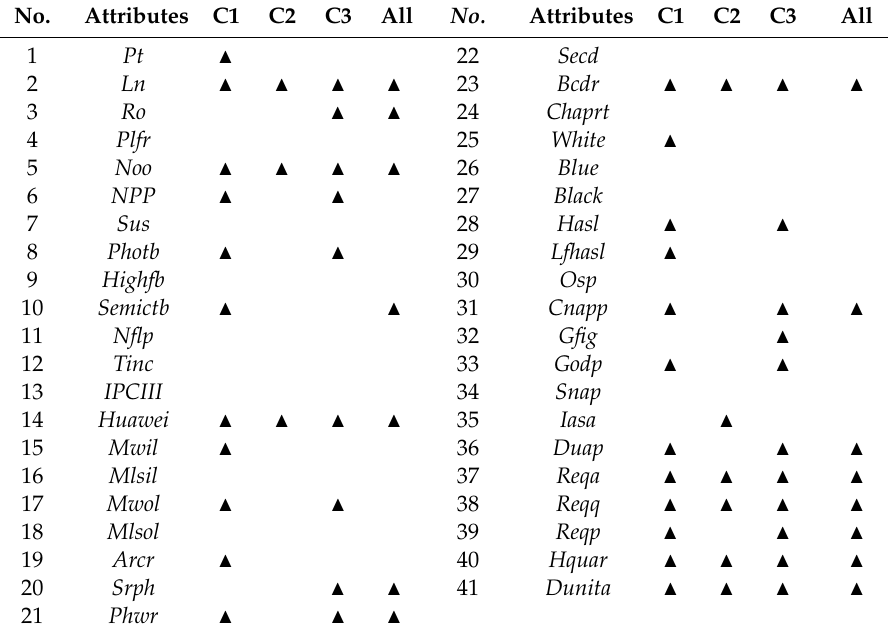
Table 4. Selected attributes for each category / all samples.